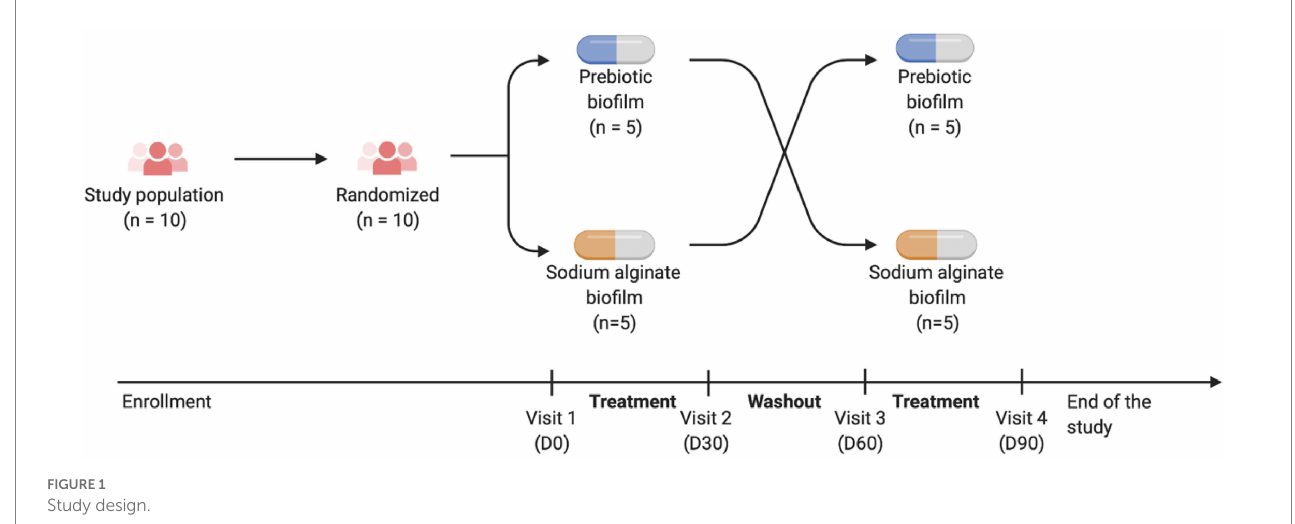
FIGURE 1 Study design.